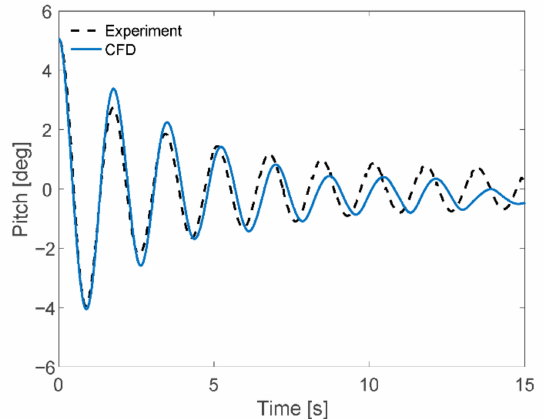
Figure 7. Comparison of experiment and CFD simulation of pitch